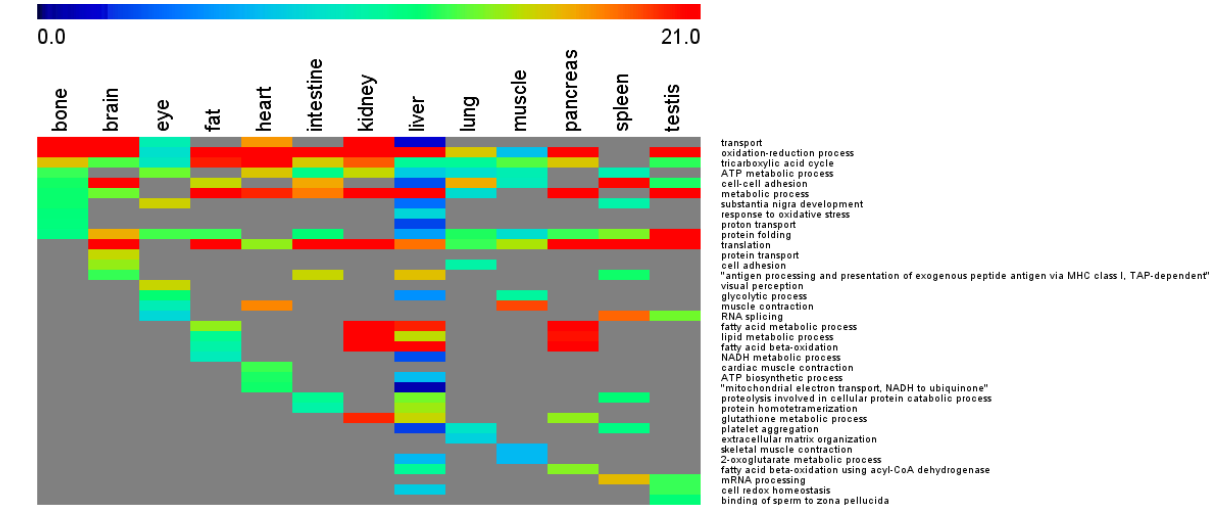
Figure 2. Gene ontology enrichment analysis of biological processes in the obtained protein lists. ( A ) Top10 enriched biological processes of filtered and partially verified organ-specific proteins (vOSPs) of each organ against four genetic backgrounds. ( B ) Top10 enriched biological processes of complete OSPs of each organ across four genetic backgrounds. ( C ) Top10 enriched biological processes of each organ proteome of